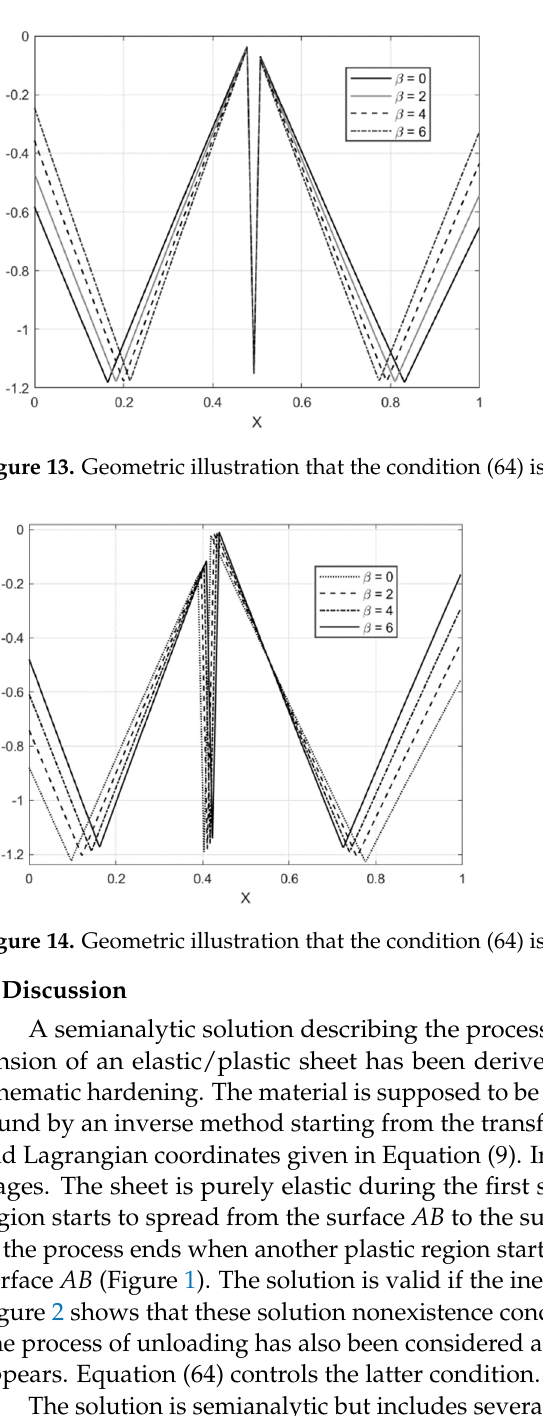
σ 0.06 H r = res σ 0.06 H r = res at , η CD at , η CD